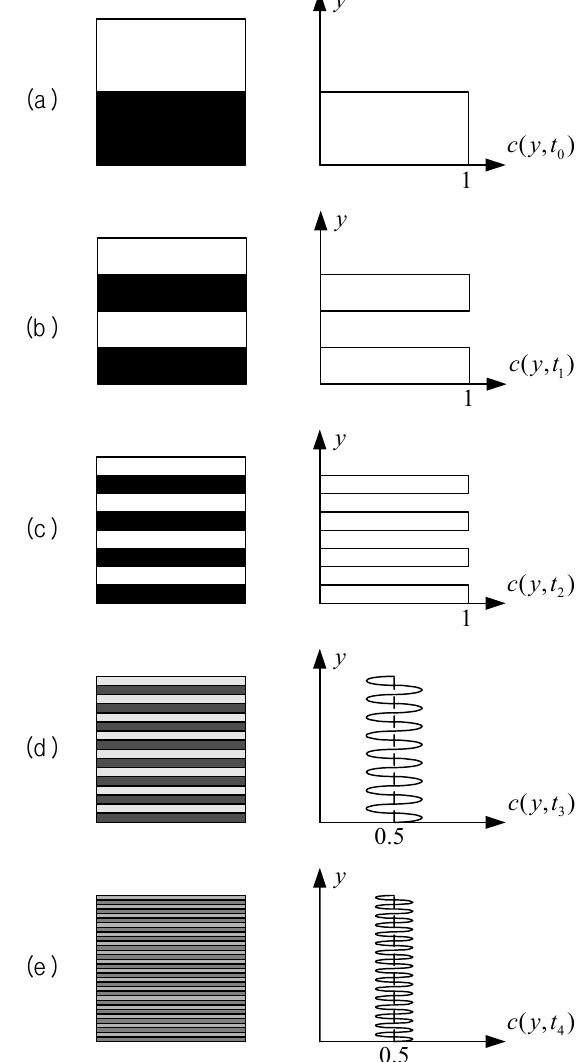
Figure 5. Typical development of the striation pattern (left) and the concentration distribution (right) given by the chaotic advection and the molecular diffusion of the chaotic mixing mechanism. Profiles in (a) to (c) should also look smooth like in (d) and (e) but the chaotic advection has been